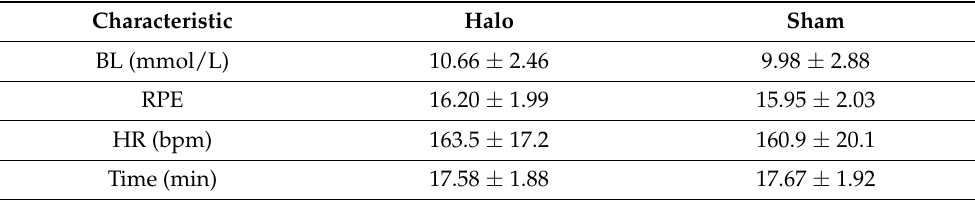
Table 2. Results of Halo and sham on BL, RPE, HR and